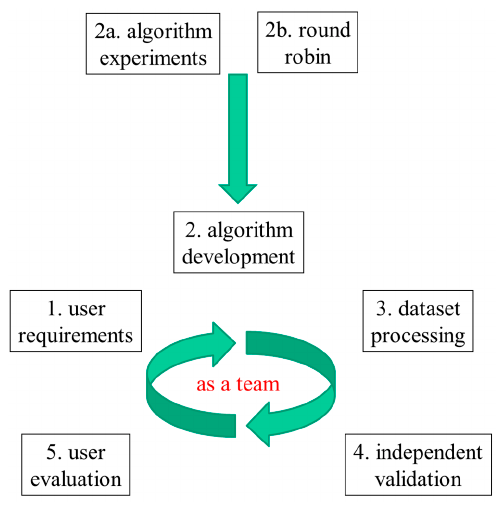
Figure 1. Overview of the cyclic evolution to produce climate quality Climate Data Records (CDRs) starting from user requirements (1) via algorithm development (2); dataset processing (3); independent validation (4) and user evaluation (5). In preparation for algorithm development, algorithm experiments (2a) and round robin exercises (2b) may be